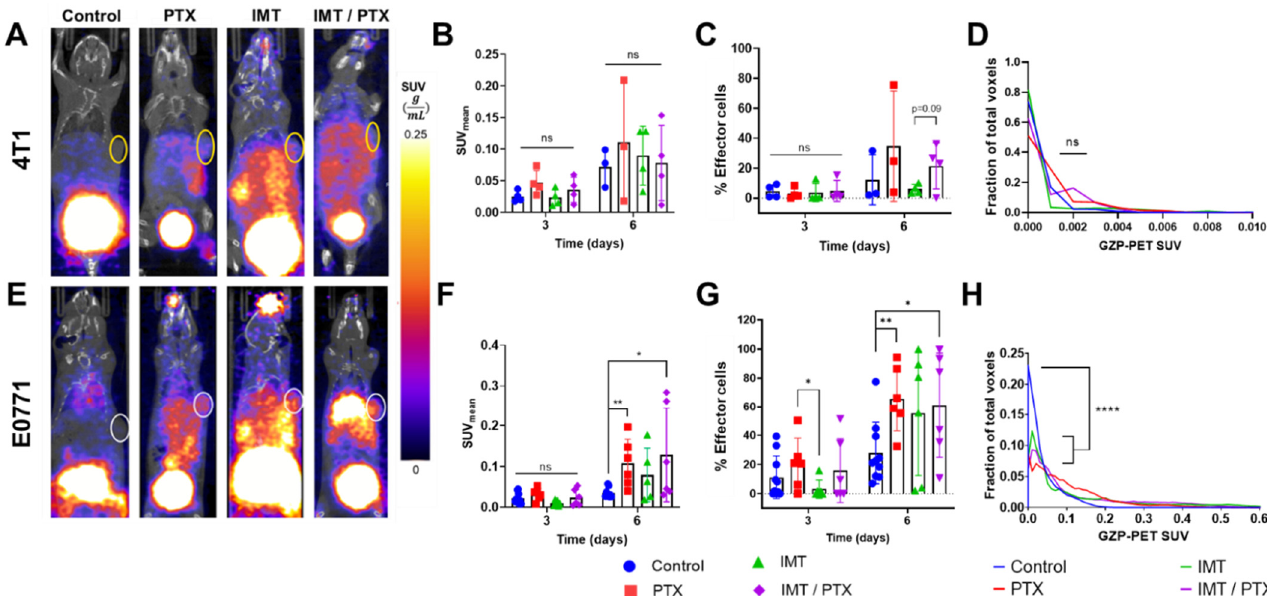
Figure 2. Granzyme B-specific positron emission tomography (GZP-PET) imaging provides quantita- tive data on triple negative breast cancer (TNBC) tumor response. Representative GZP-PET images on day six, mean standard uptake value (SUV mean ), effector cell fraction, and histogram analysis of ( A – D ) 4T1 and ( E – H ) E0771 tumors. Combination immunotherapy (IMT)/paclitaxel (PTX)-treated TNBC tumors have higher radiotracer uptake, indicating higher effector cell activation, compared to control by day six. Mean ± SD (“ns” indicates not signficiant, p > 0.05, * indicates p < 0.05, ** indicates p < 0.01, **** indicates p < 0.0001; multiple t -tests).